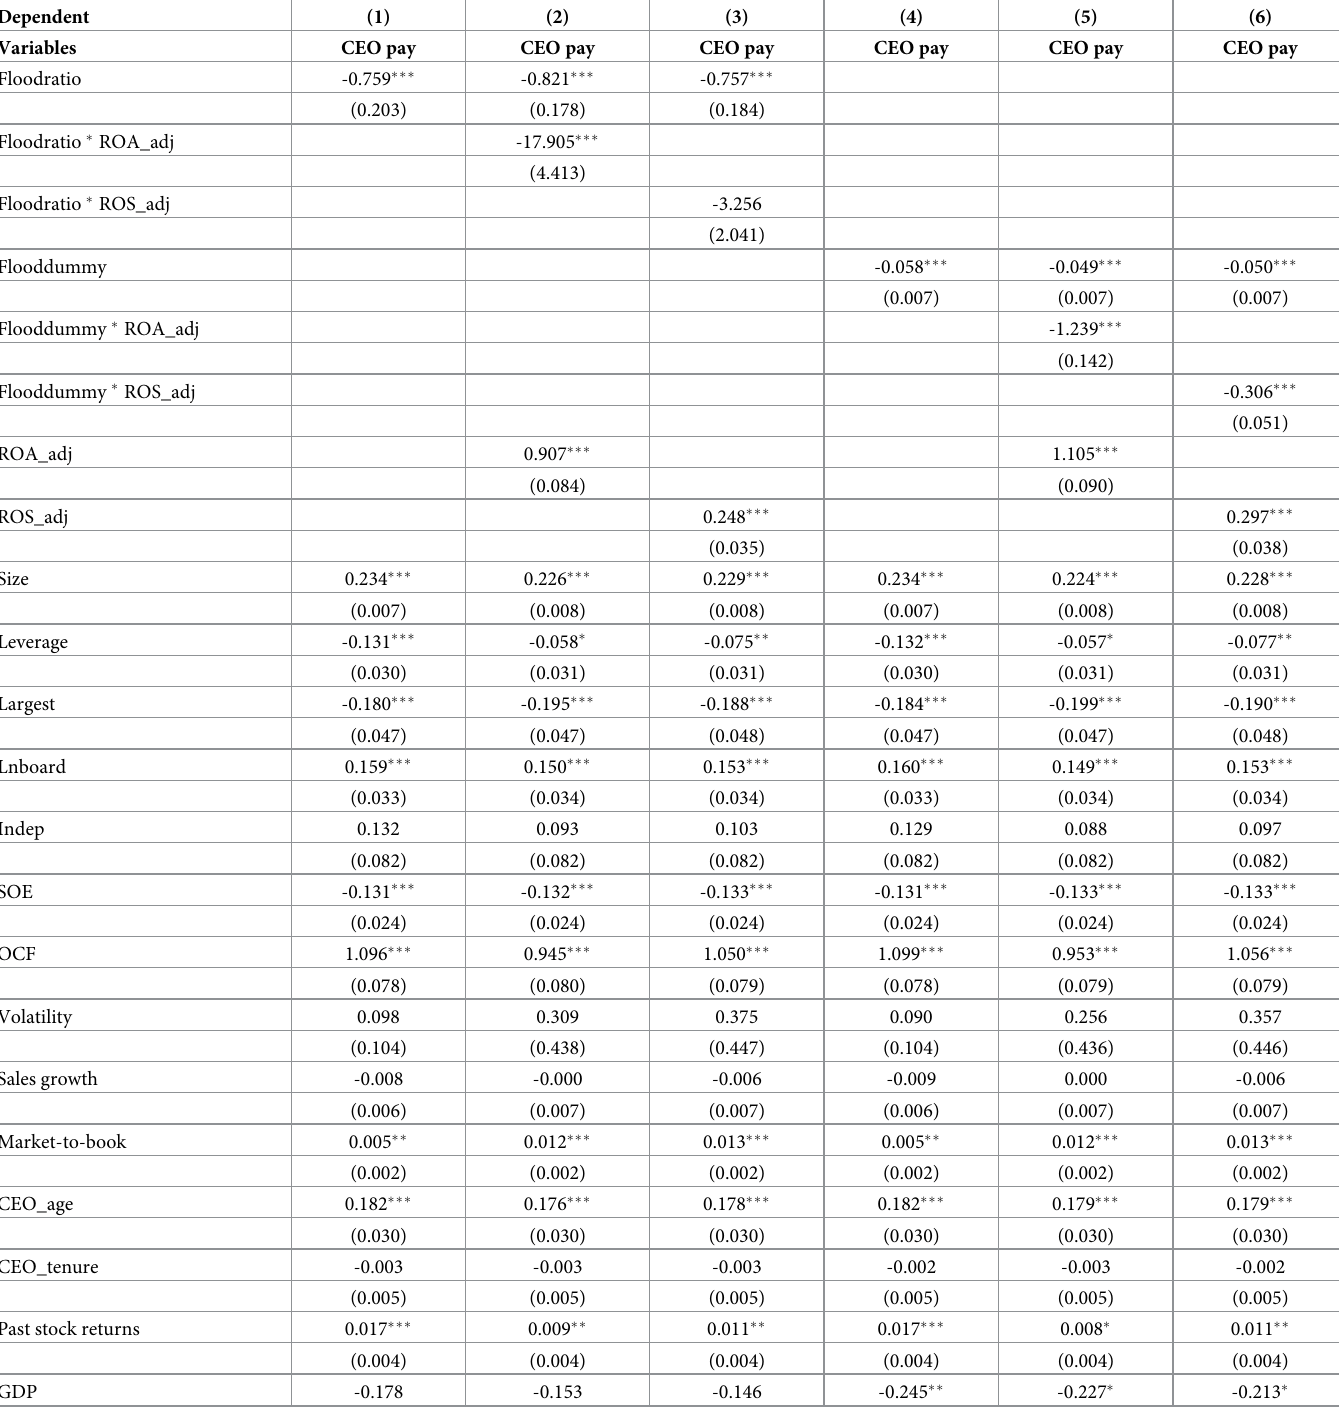
Table 9. Flooding, CEO pay and CEO pay-performance relationship. This table reports the regression results of the effects of flooding on total CEO pay and CEO pay- performance sensitivity. Dependent variable is the natural logarithm of the CEO total compensation. An interaction term between Floodratio and relative firm perfor- mance is included to measure the CEO pay-performance sensitivity. Relative firm performance proxies are measured by removing the industry median value in each year. Variable definitions are in Table A1 in the S1 Appendix. Robust standard errors are clustered at the city-year level and reported in parentheses. � , �� and ��� indicate the significance levels at 10%, 5% and 1%,